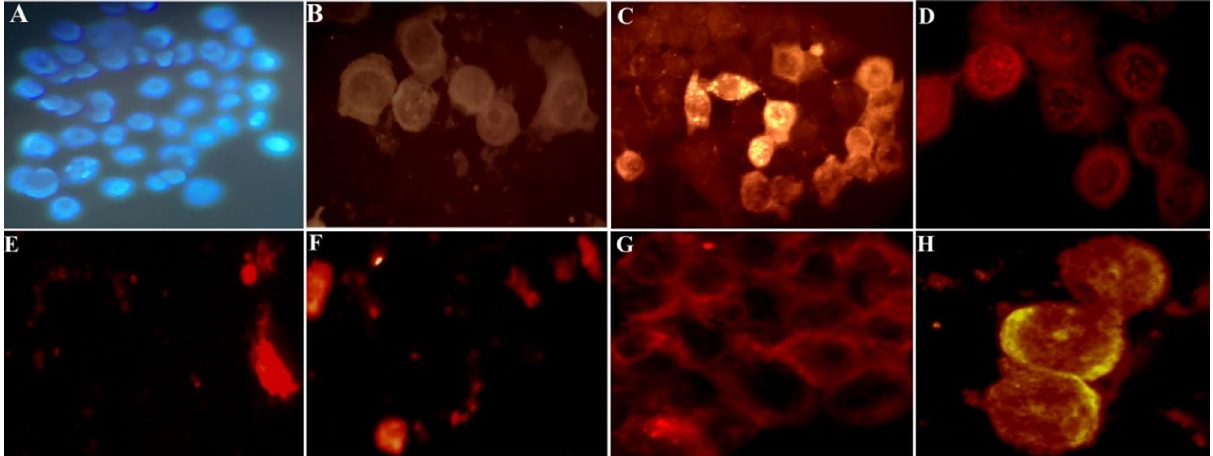
Figure 4. HT-29 CRC cell death detection by TUNEL assay after 24hrs. Apoptotic cells presented their morphology by taking up fluorescent dye. ( A ) The nucleus of untreated cells stained with DAPI (100 × magnification). ( B ) Control. ( C ) Cells treated with Na 2 S (IC 50 : 5 mM). ( D ) Cells treated with SNP (IC 50 : 10-6 M). E. Cells treated with 5-FU (11.25 µM after five days). ( F ) Cells treated with the combination of 5-FU and Na